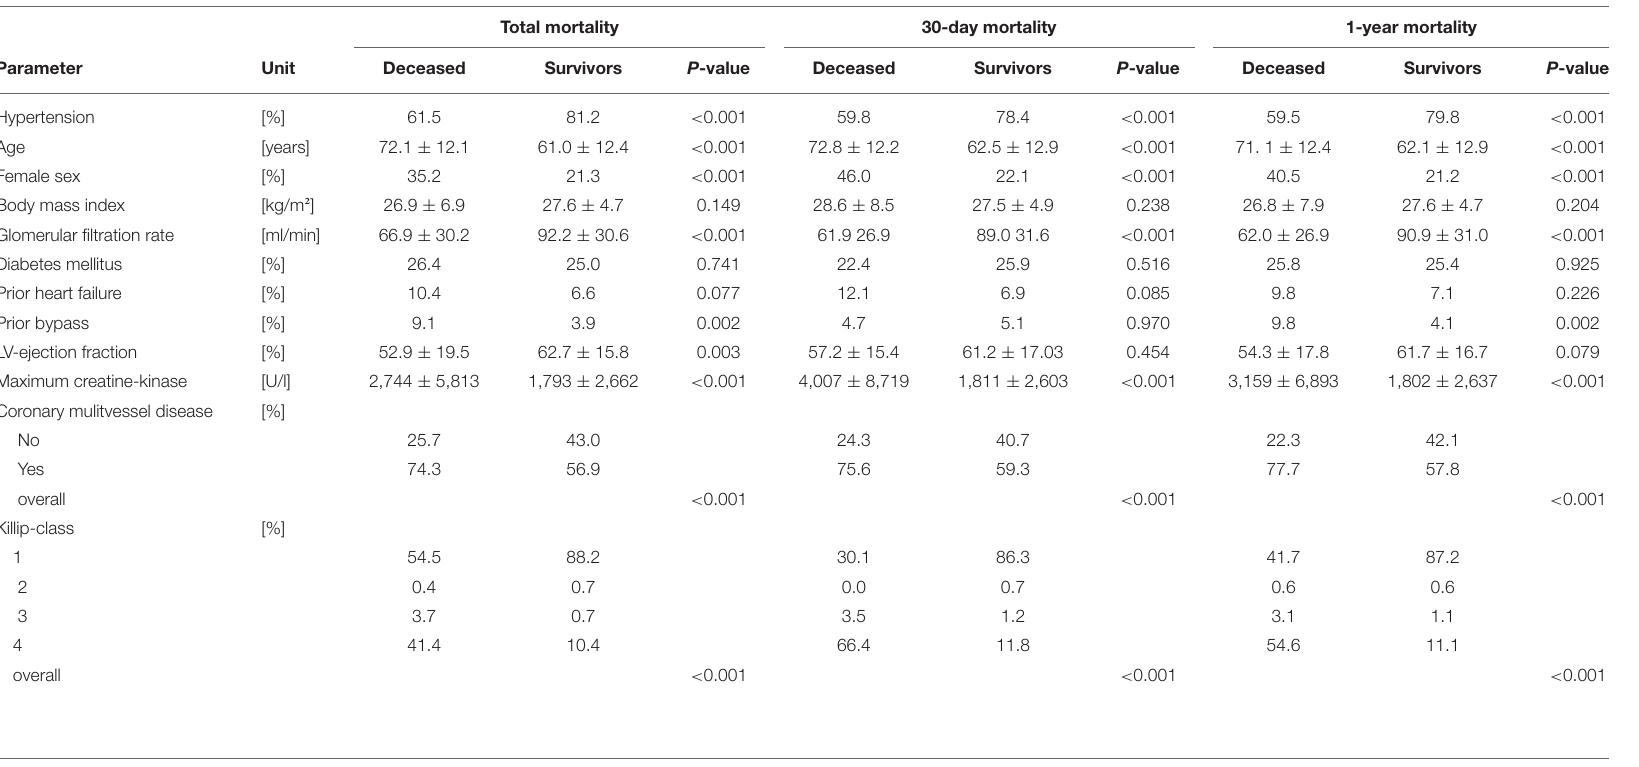
TABLE 2 | Survival